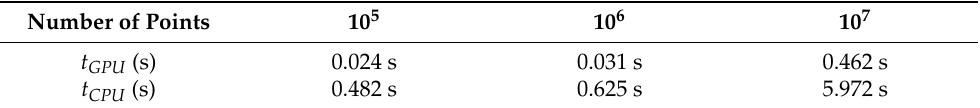
Figure 3. ( a ) A rectangle box surrounding two overlapping particles; ( b ) Point sampling details based on one-point correlation function: the red dots indicate the overlapped ones, and the black dot is the centroid.